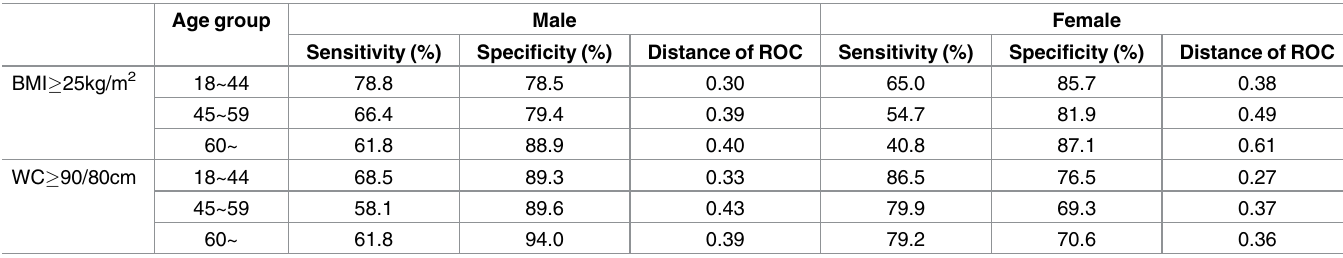
Table 7. The clusters of risk factors for MS predicted by cut-off point of WC and BMI in different age groups. Age